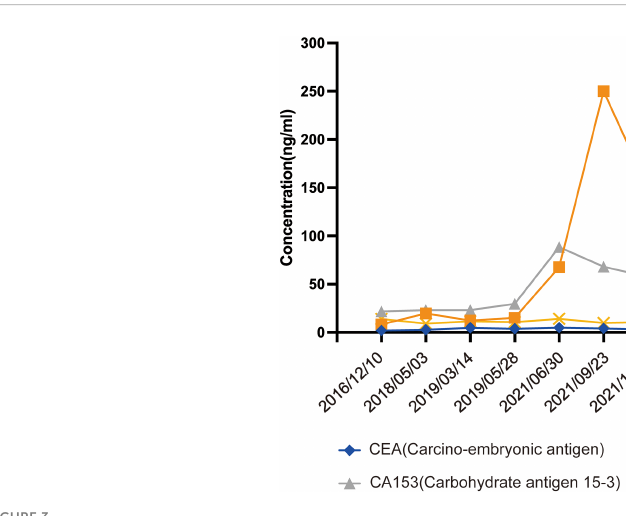
FIGURE 3 Serum tumor biomarker during